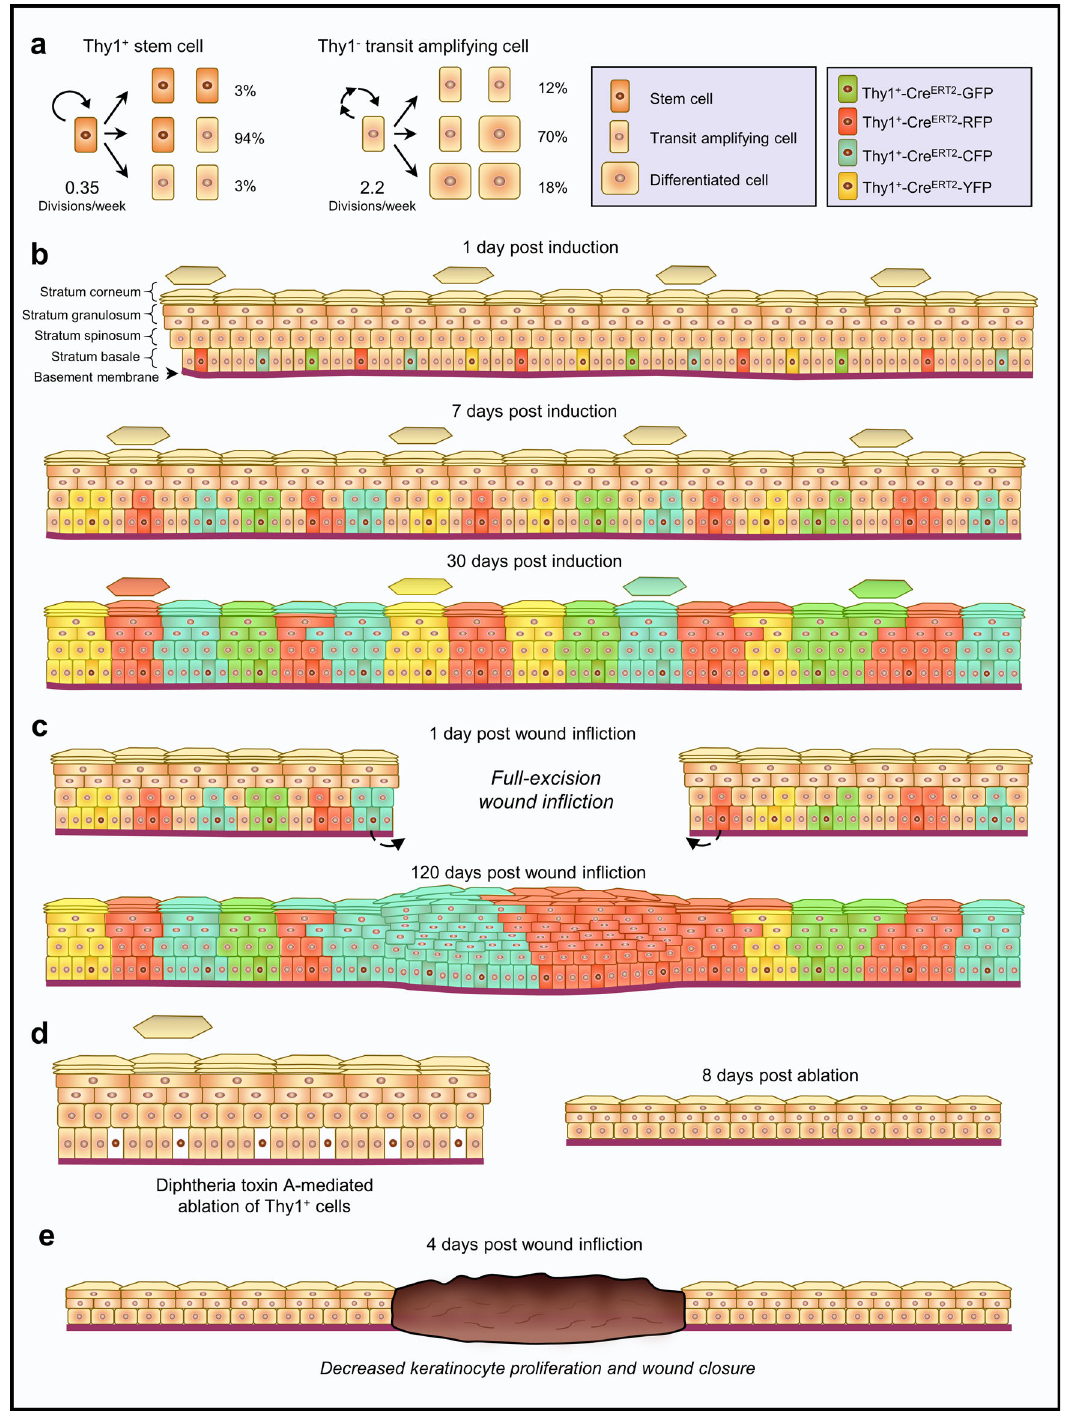
Fig. 7 Schematic of Thy1 + stem cell dynamics and contributions in the mouse skin. a Division fates of Thy1 + stem cells and progenitor cells in the mouse epidermis. b Clonal Thy1 + basal cell-derived events post induction. c Clonal Thy1 + basal cell-derived events post induction and wounding of the skin. d , e Outcome of Thy1 + cell ablation in the ( d ) homeostatic, and ( e ) wounded mouse